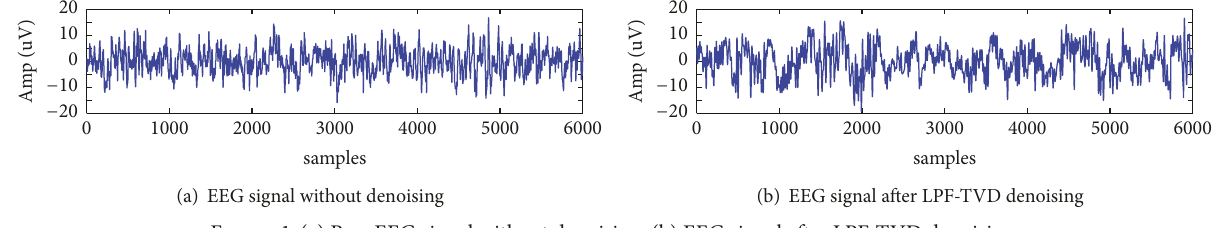
Figure 1: (a) Raw EEG signal without denoising; (b) EEG signal after LPF-TVD denoising.